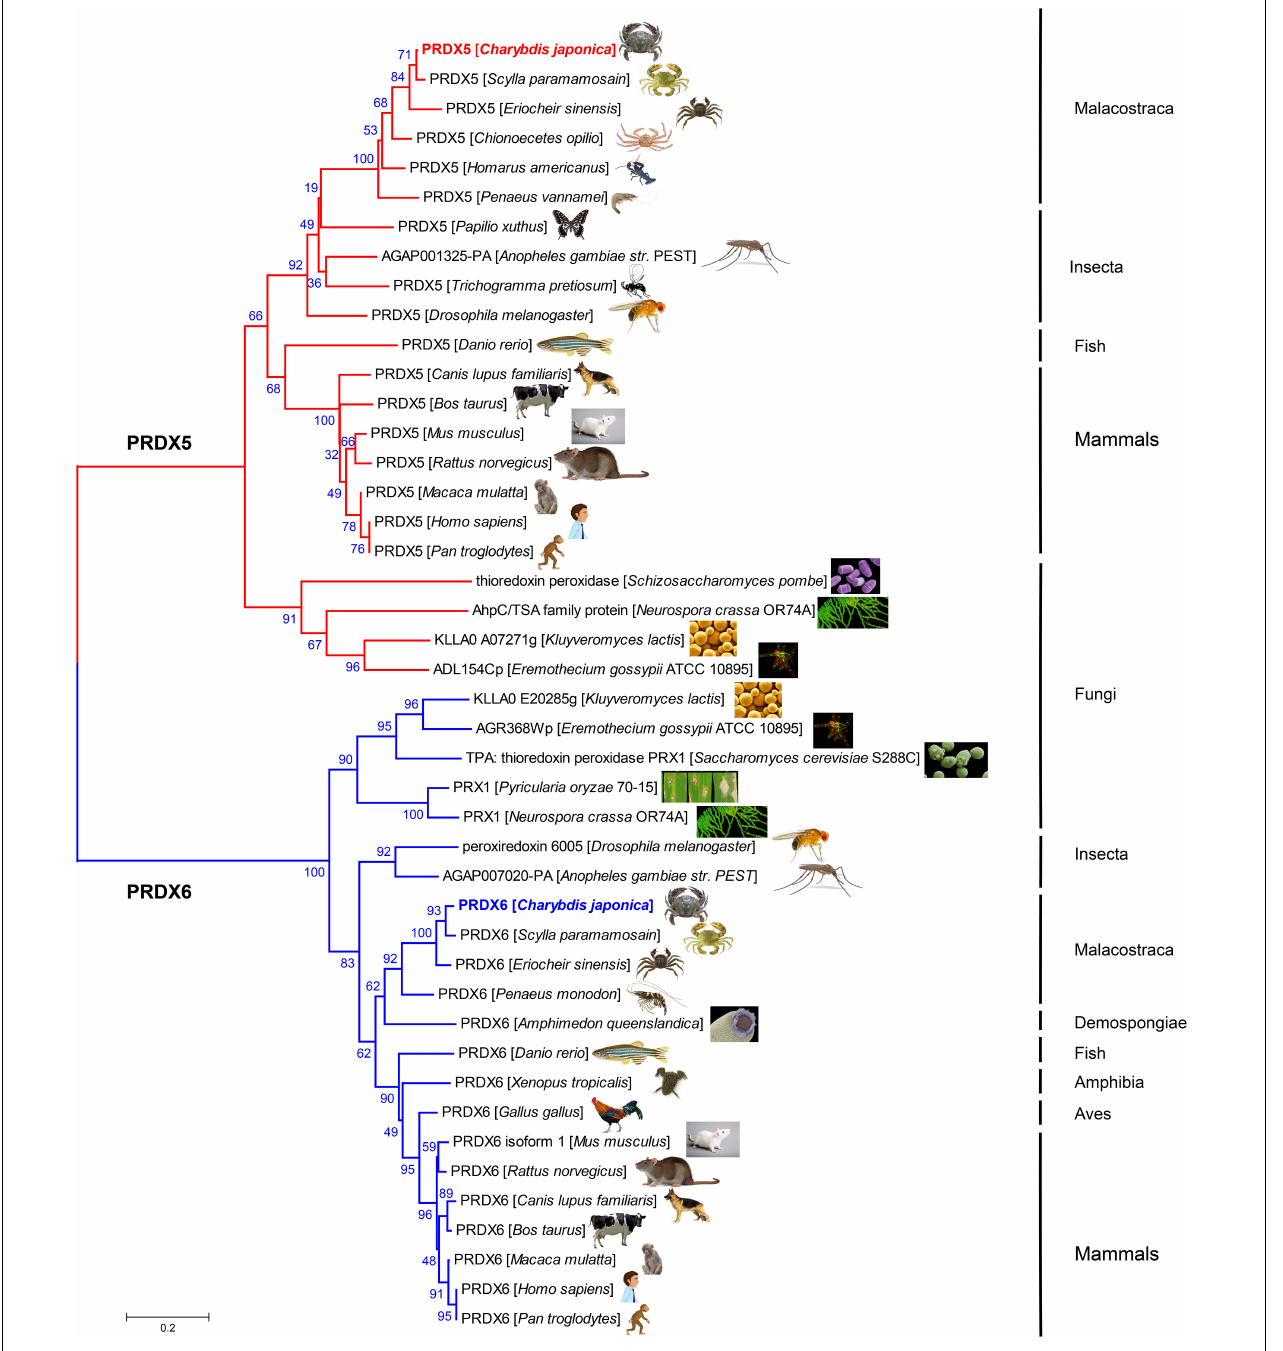
FIGURE 3 | Evolutionary relationships of PRDX5 and PRDX6 amino acid sequence of C. japonica and other